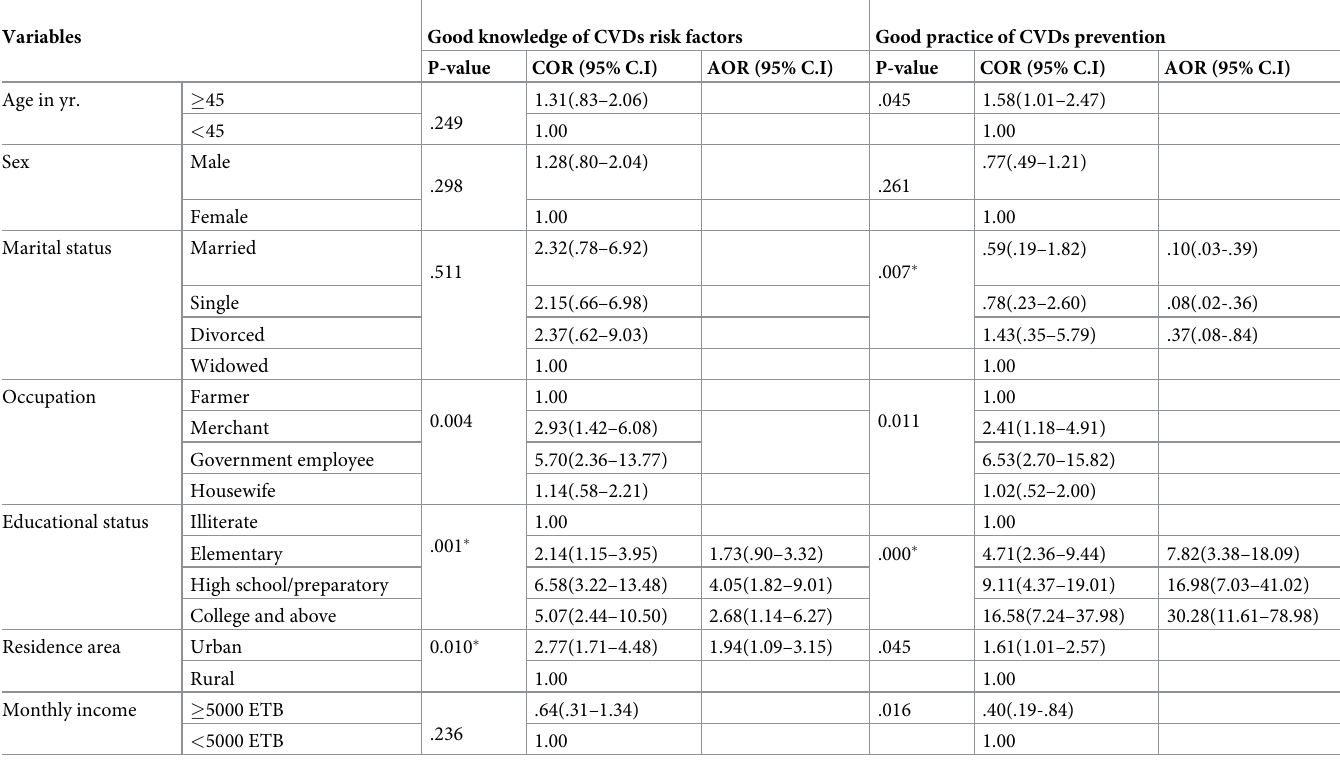
Table 4. Factors associated with knowledge of modifiable cardiovascular diseases risk factors and its primary prevention practices among diabetic mellitus patients who were on follow-up at Jimma University Medical Centre, 2021.